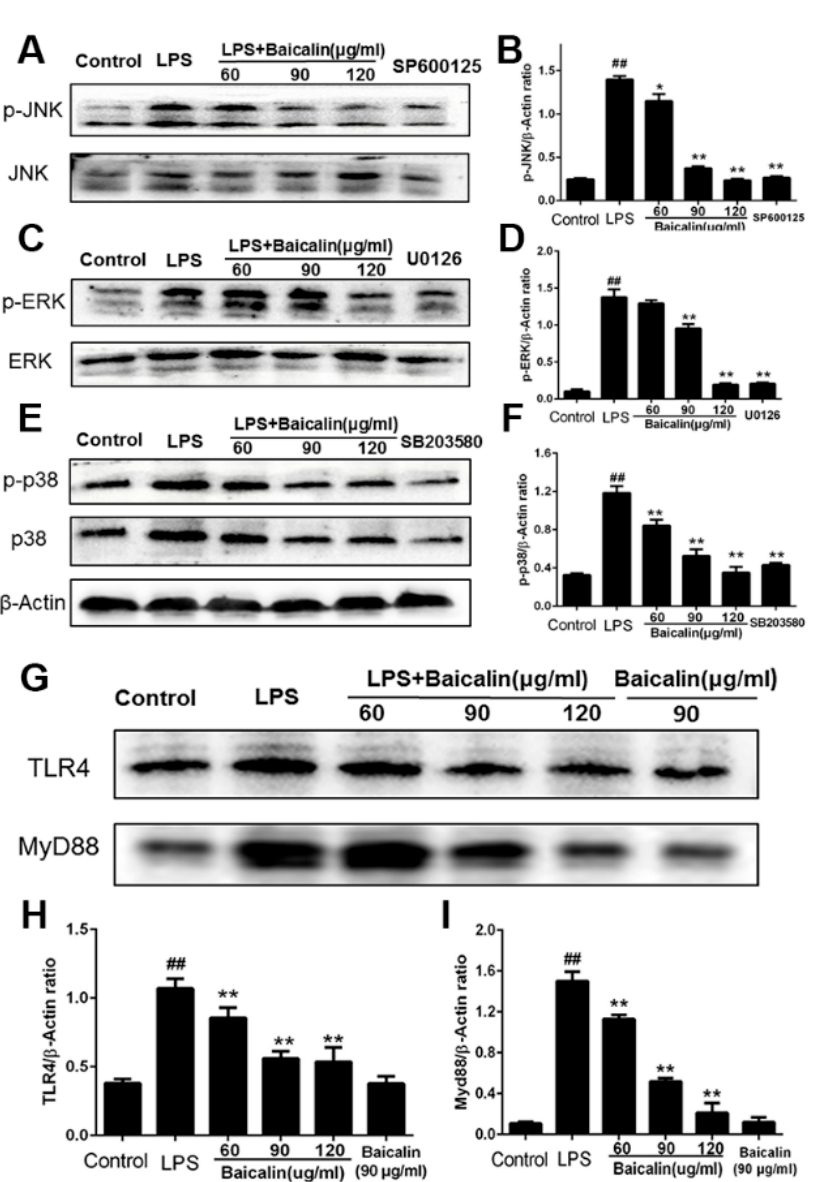
Figure 3. Effect of baicalin on protein expression in MAPK and TLR4 pathway of RAW 264.7 cells. Cells were treated with LPS (4 µ g/mL), baicalin (60, 90, and 120 µ g/mL), SP600125 (10 µ M), U0126 (10 µ M), or SB203580 (10 µ M). ( A , B ) Protein expression of p-JNK and JNK; ( C , D ) protein expression of p-ERK and ERK. ( E , F ) Protein expression of p-p38 and p38; ( G – I ) protein expression of TLR4 and MyD88. ## p < 0.01 vs. control; * p < 0.05 vs. LPS; ** p < 0.01 vs.